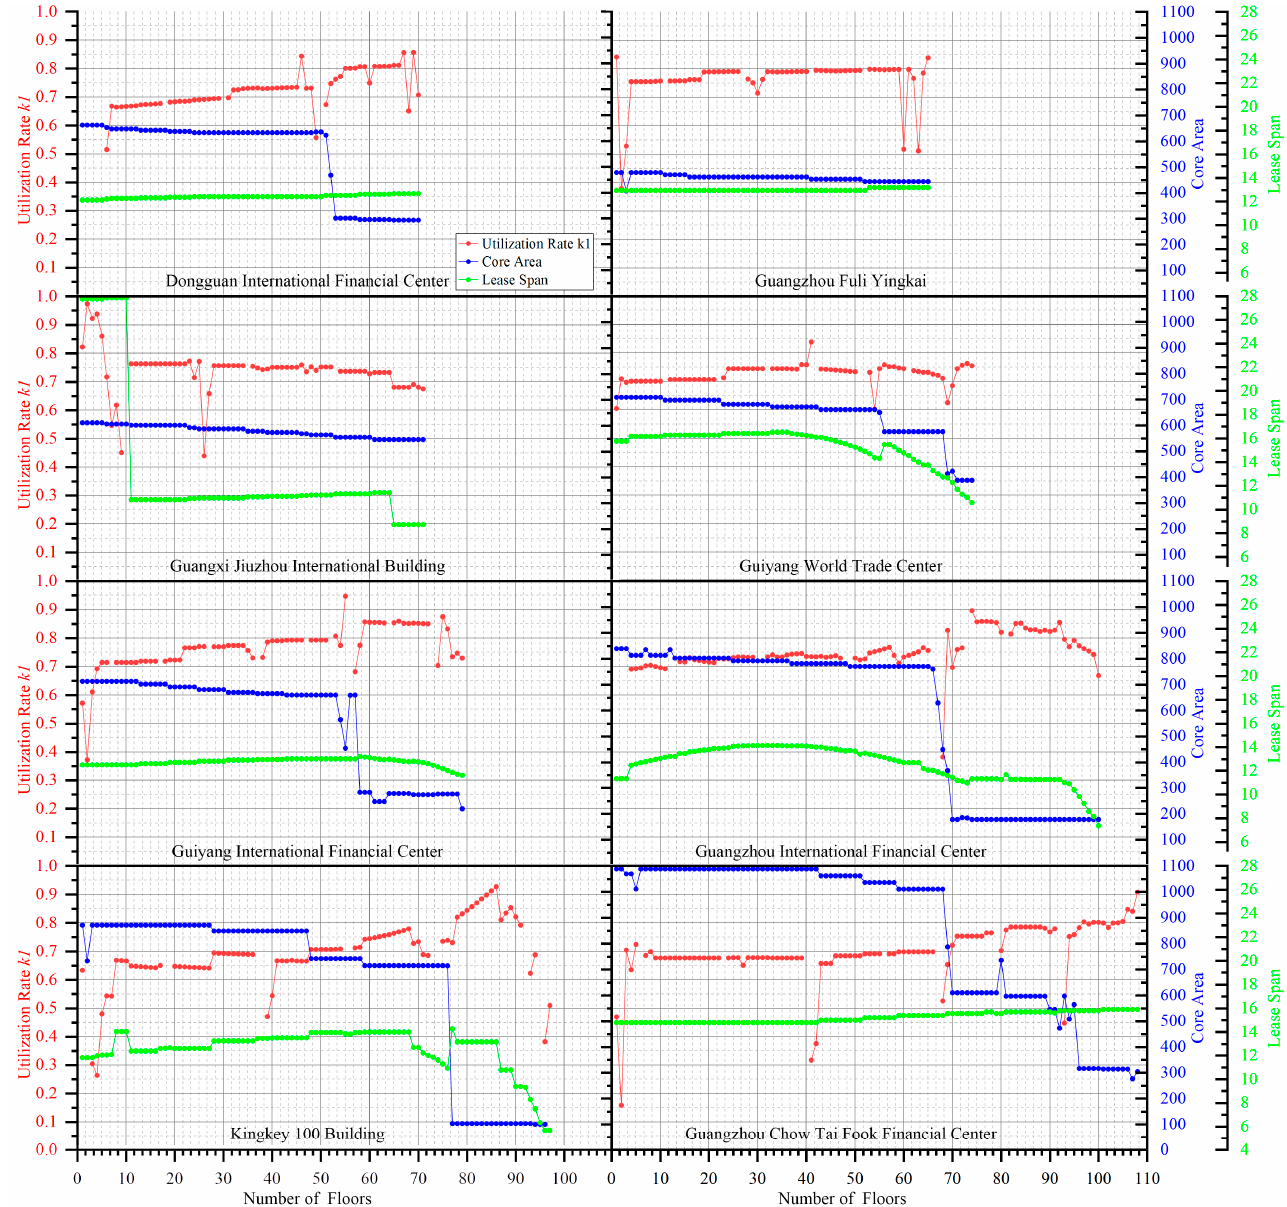
Figure 21. Relationship between the typical floor utilization rate k 1 , core area, and the lease